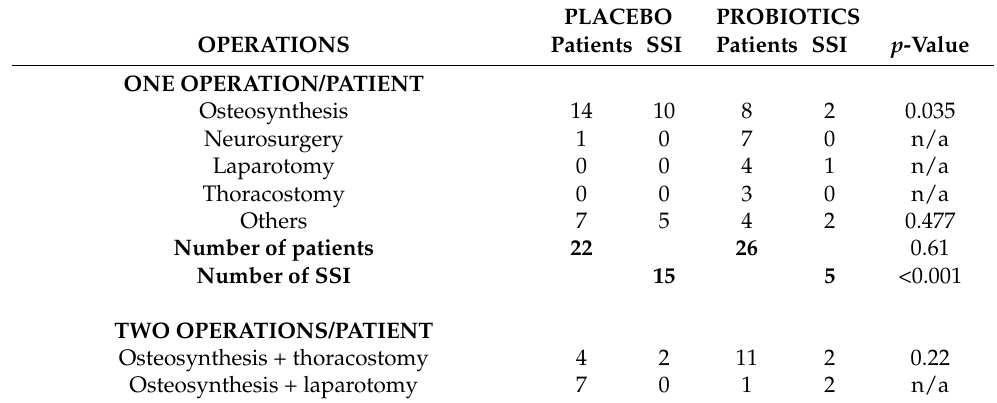
Table 4. SSI infections occurred in relation to the number and type of operations in each